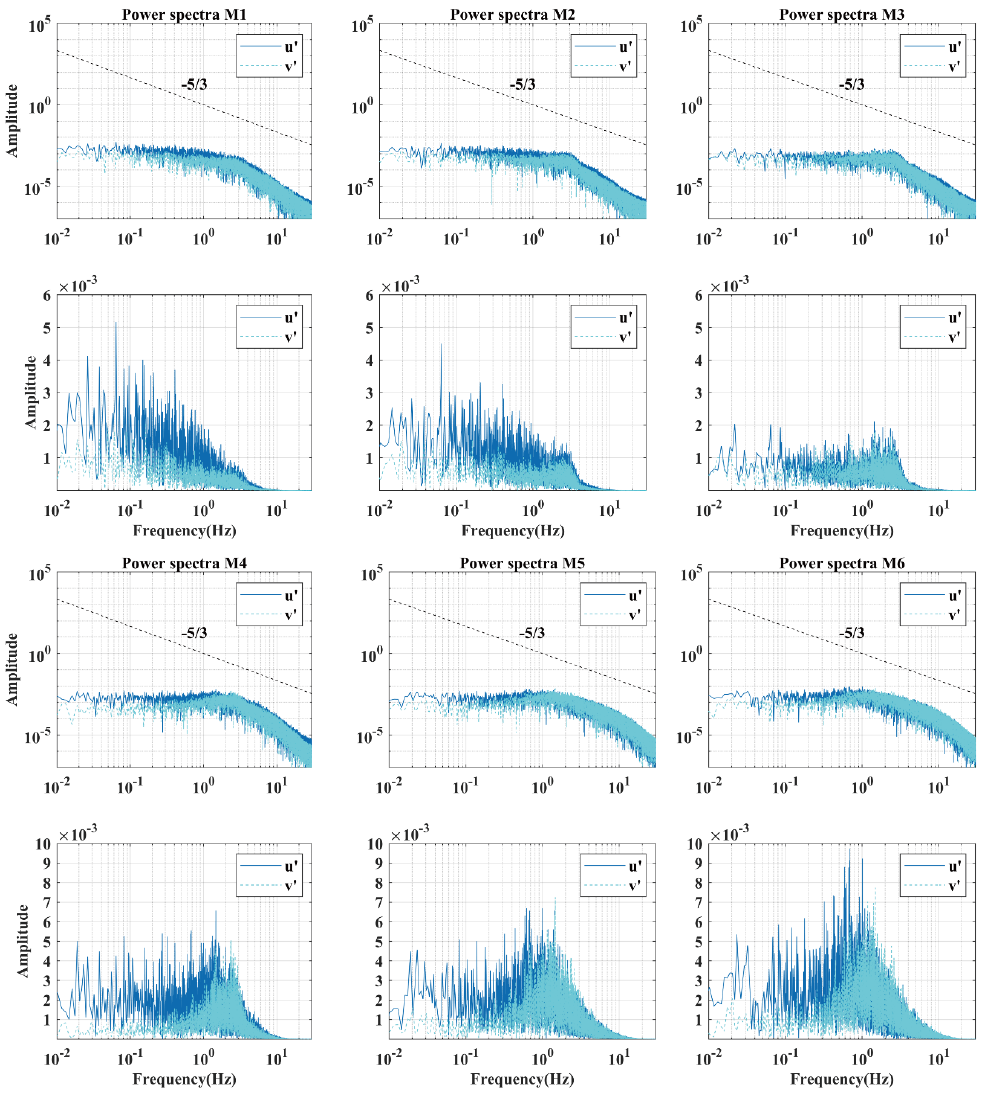
Figure 14. Power spectra of streamwise and spanwise velocity fluctuation time series at the location z / H = 0.51 for Case 2 in log–log scale and semi-log scale.